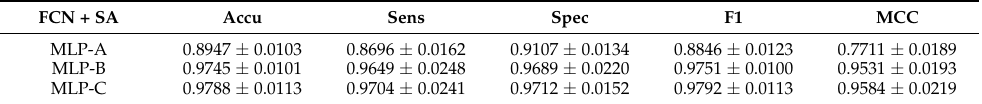
Table 7. The classification performance of the MLP models after adding the self-attention